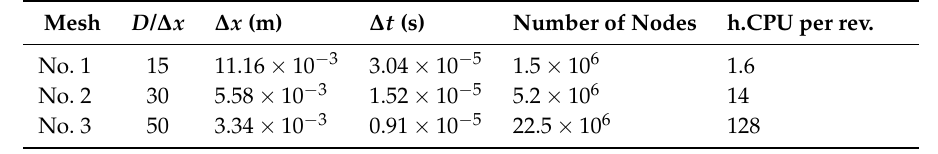
Table 2. Configurations for the ALM-LBM mesh sensitivity study. h.CPU is wall-clock-time multiplied by the number of CPU used.